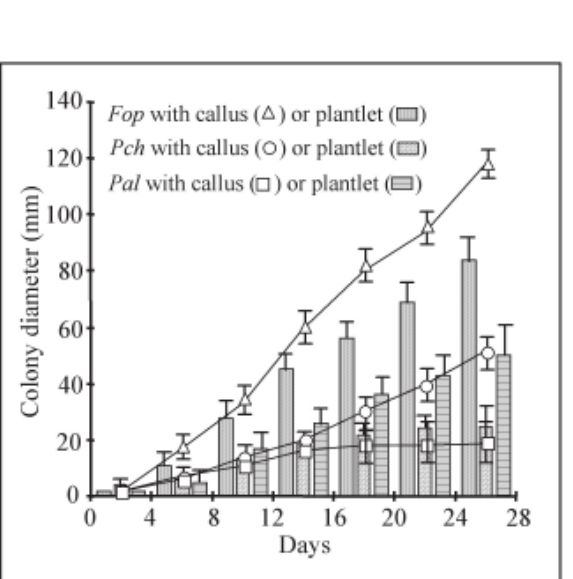
Fig. 6. Effect of calli or vitroplantlets of grapevine cv. Italia on the growth rates of Fomitiporia punctata ( Fop ) , Phaeomoniella chlamydospora ( Pch ) and Phaeoacremo- nium aleophilum ( Pal ). Standard error bars are shown.